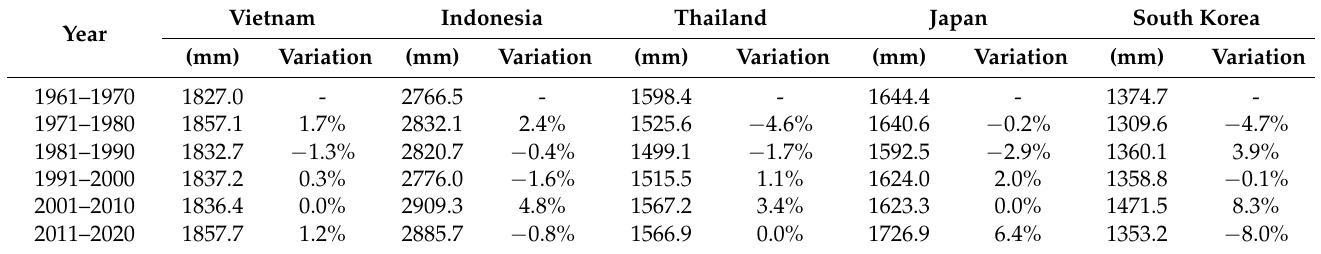
Figure 14. Average annual precipitation anomalies in ( a ) Vietnam, ( b ) Indonesia, ( c ) Thailand, ( d ) Japan, and ( e ) South Korea. These data range from 1961 to 2020. (Source: data retrieved from [4,84]). Table 14. The 10-year average of annual precipitation and variations between each decade in Vietnam, Indonesia, Thailand, Japan, and South Korea from 1961 to 2020. (Source: data retrieved from [4,84]).